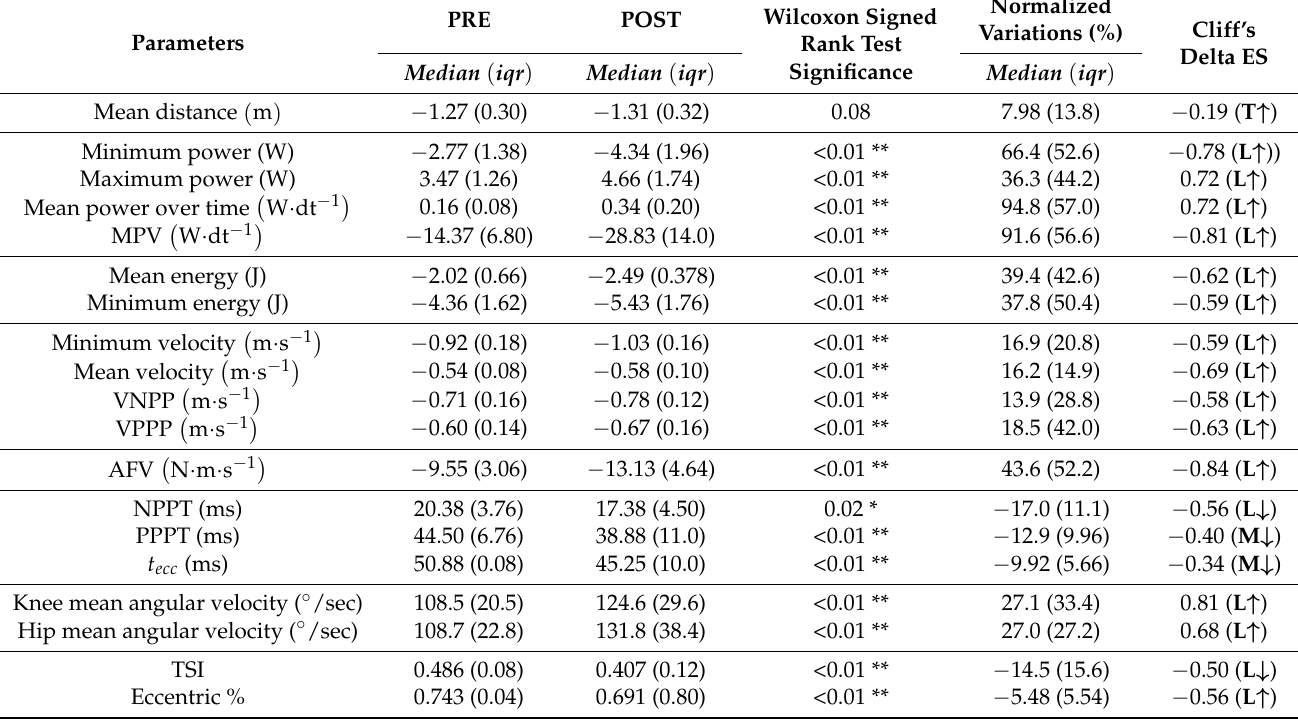
Table 4. Kinematic parameters (PAP group).